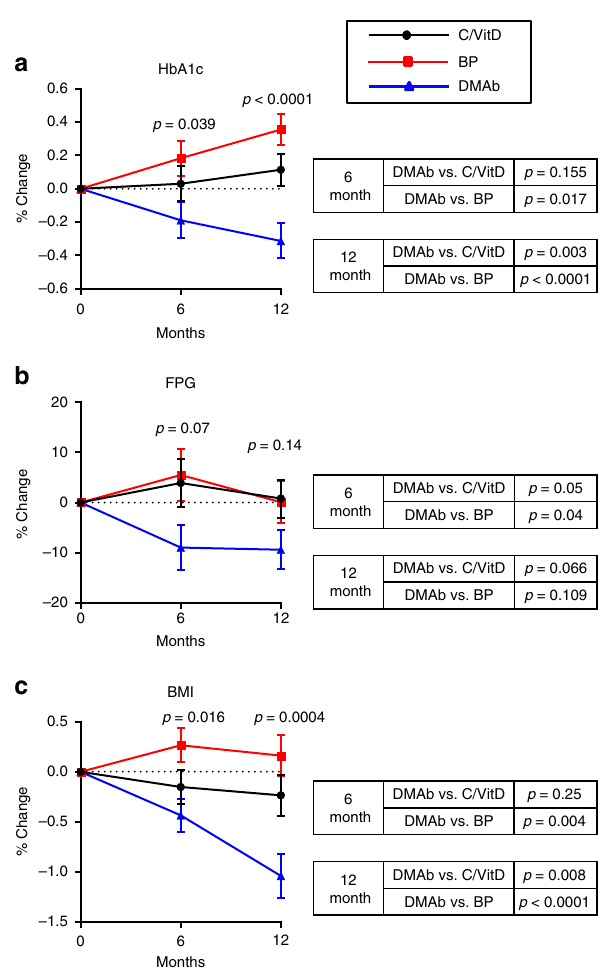
Fig. 5 Analysis of type 2 diabetic/prediabetes patients treated with DMAb. a HbA1c, b fasting plasma glucose (FPG), and c BMI are plotted for patients treated with calcium plus vitamin D (C/VitD, black solid line and circles), bisphosphonate (BP, red squares), or DMAb (blue triangles) ( N = 115 patients per group). The y -axis shows percent change from baseline. Analysis of covariance (ANCOVA) was used to test for differences in continuous measures among the three groups. Bonferroni correction was used for post hoc pairwise comparisons. Mean percent change from baseline is presented at 6 and 12 months. Error bars represent SD. Source data are provided as a Source Data fi